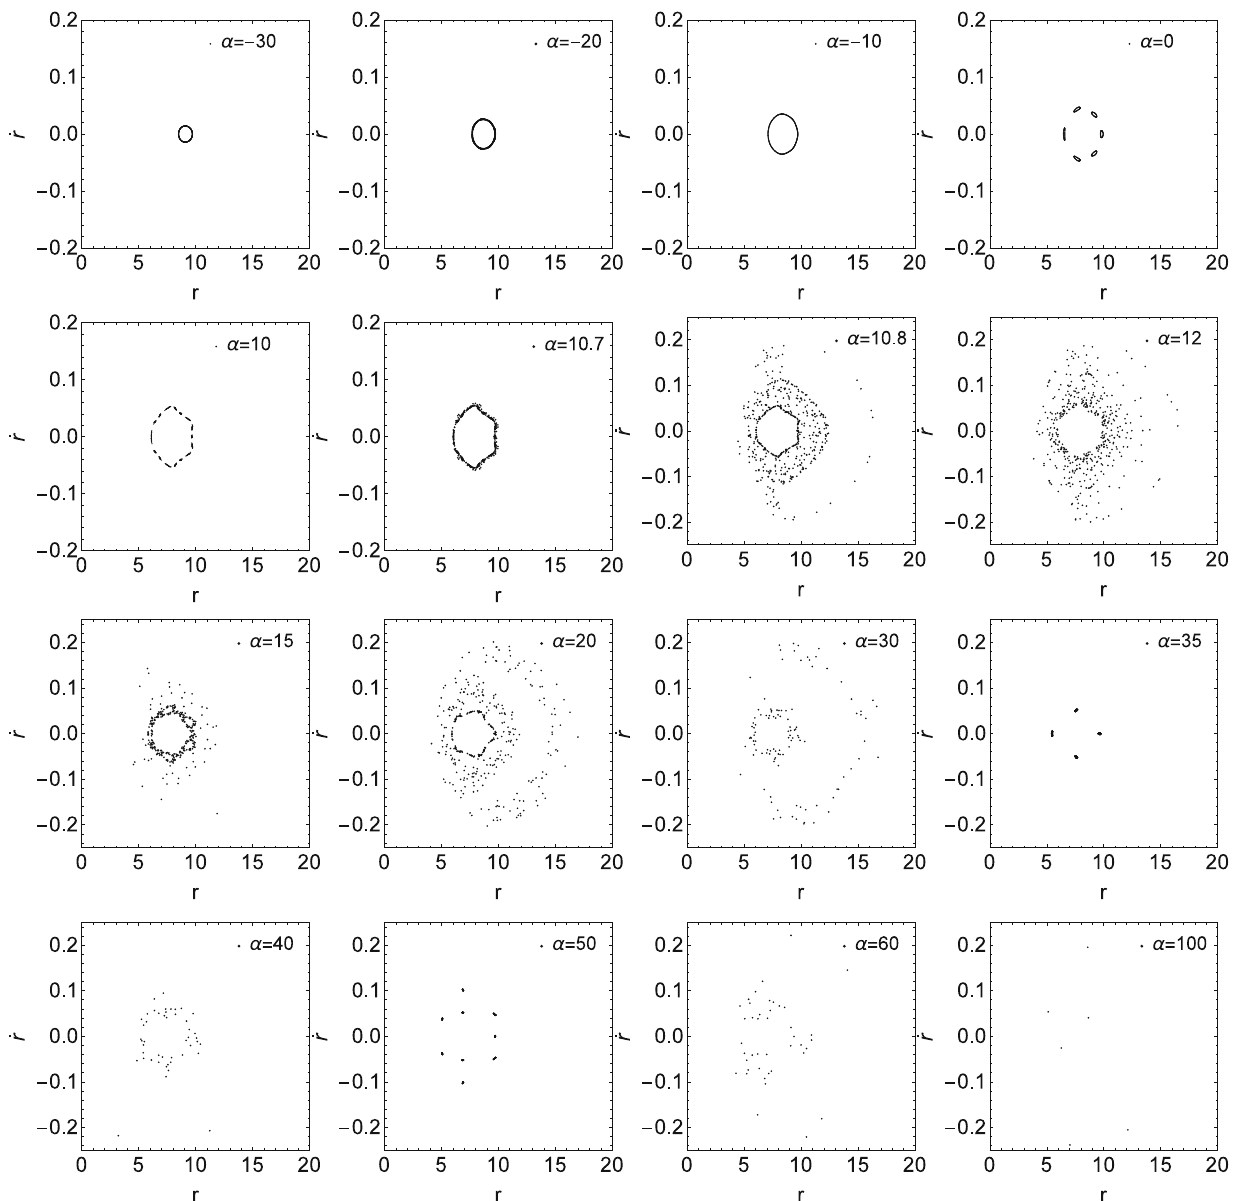
Fig. 4 ThePoincarésurfaceofsection( θ = π θ( 0 ) = π and ˙ r ( 0 ) = 2